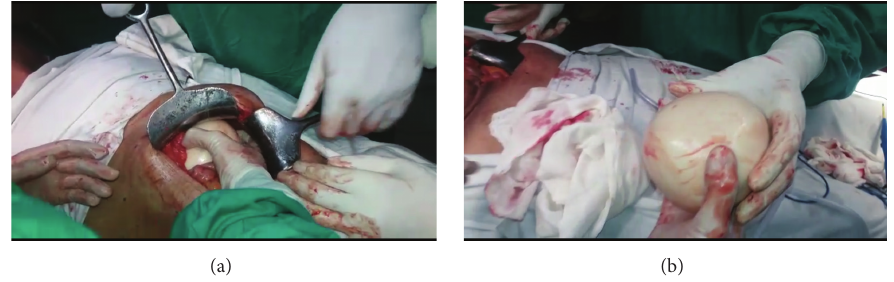
Figure 2: Intraoperative appearance of tumour.